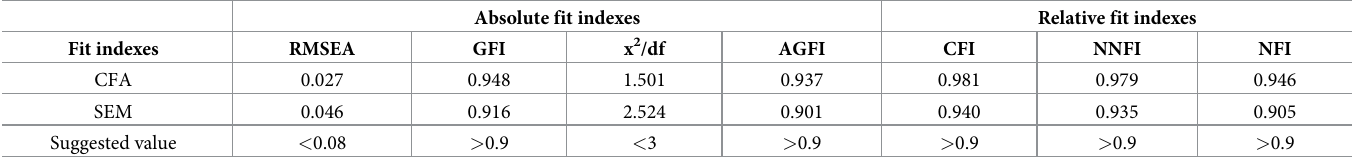
Table 6. Fit index